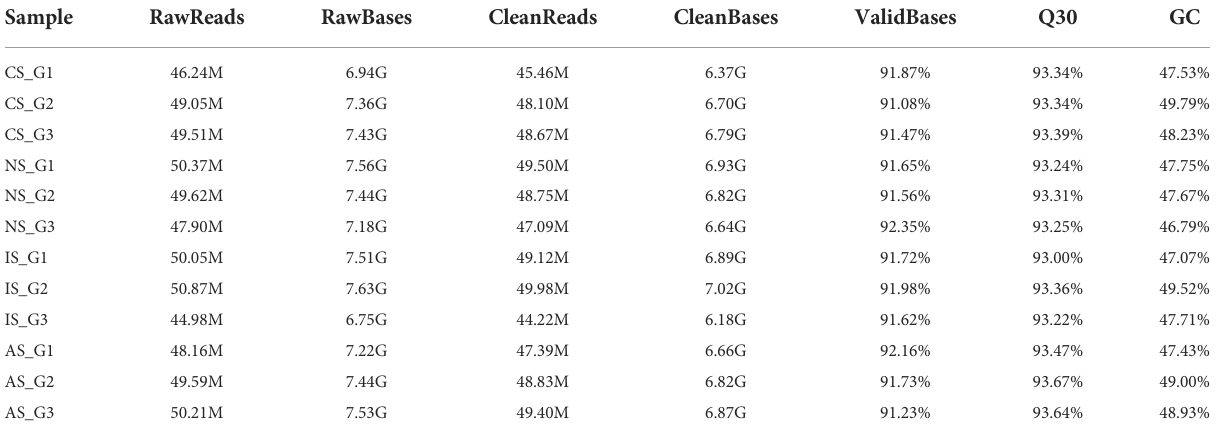
TABLE 1 Sequencing sample data and quality control.